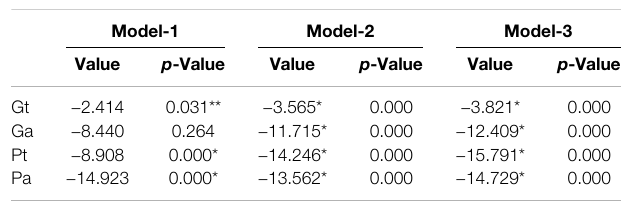
TABLE 6 | cointegration